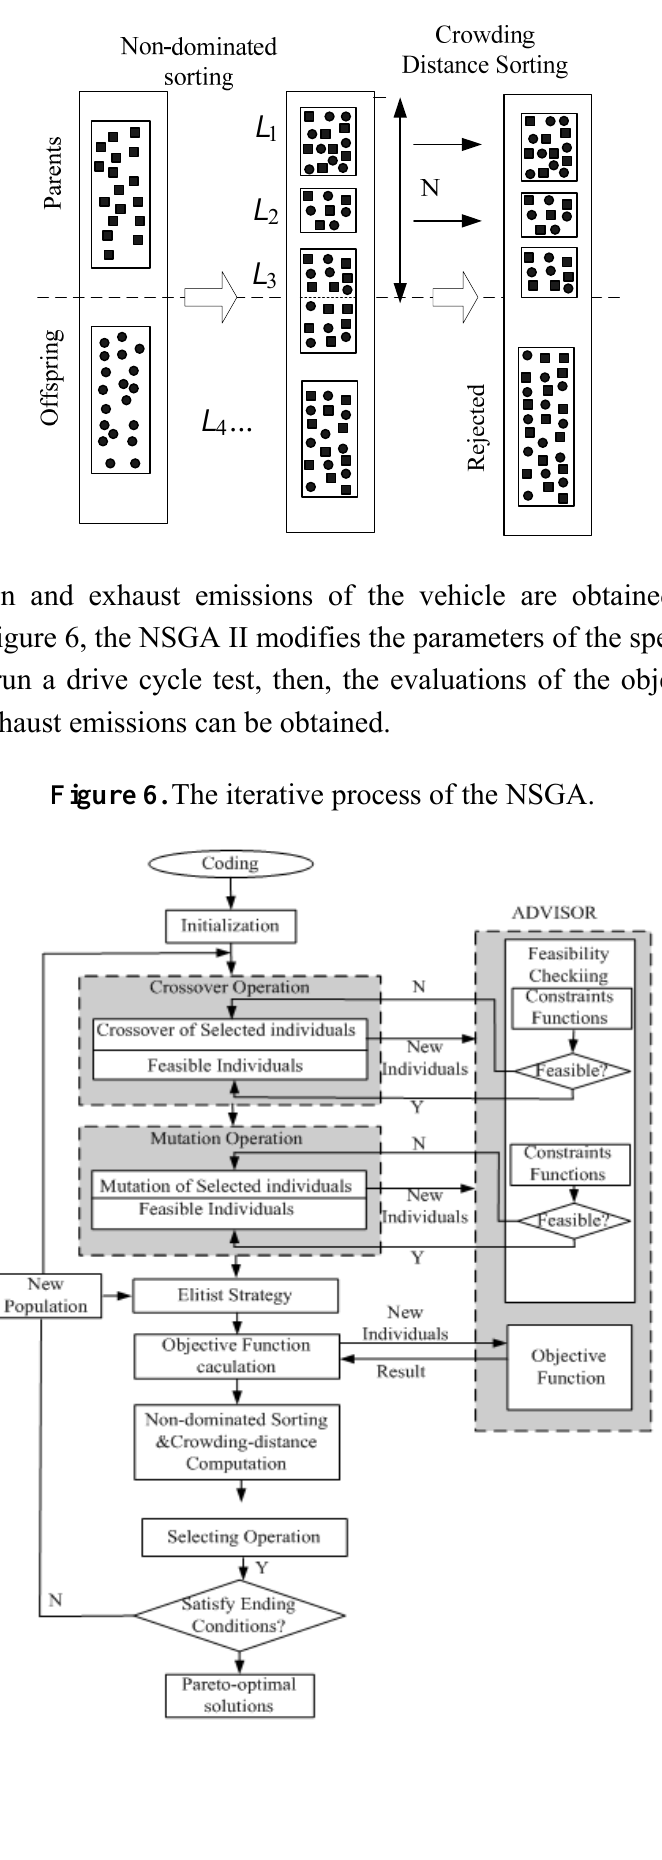
Figure 5. Selection procedure of NSGA II.